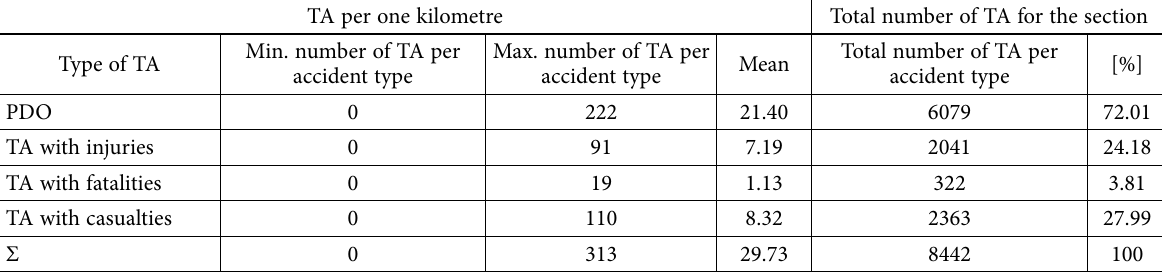
Table. Data and variations that were used in the number of Traffic Accidents (TA) for the period of 2001–2011 TA per one